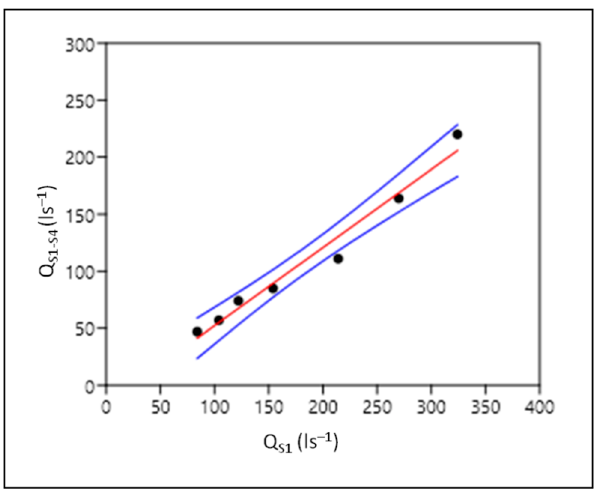
Figure 5. Linear regression (or rating line; red continuous line) linking discharges at S1 (Q S1 ) to total stream losses along the alluvial fan (Q S1–S4 ). Error bounds (blue continuous lines) corresponding to the 95% confidence intervals are also reported.